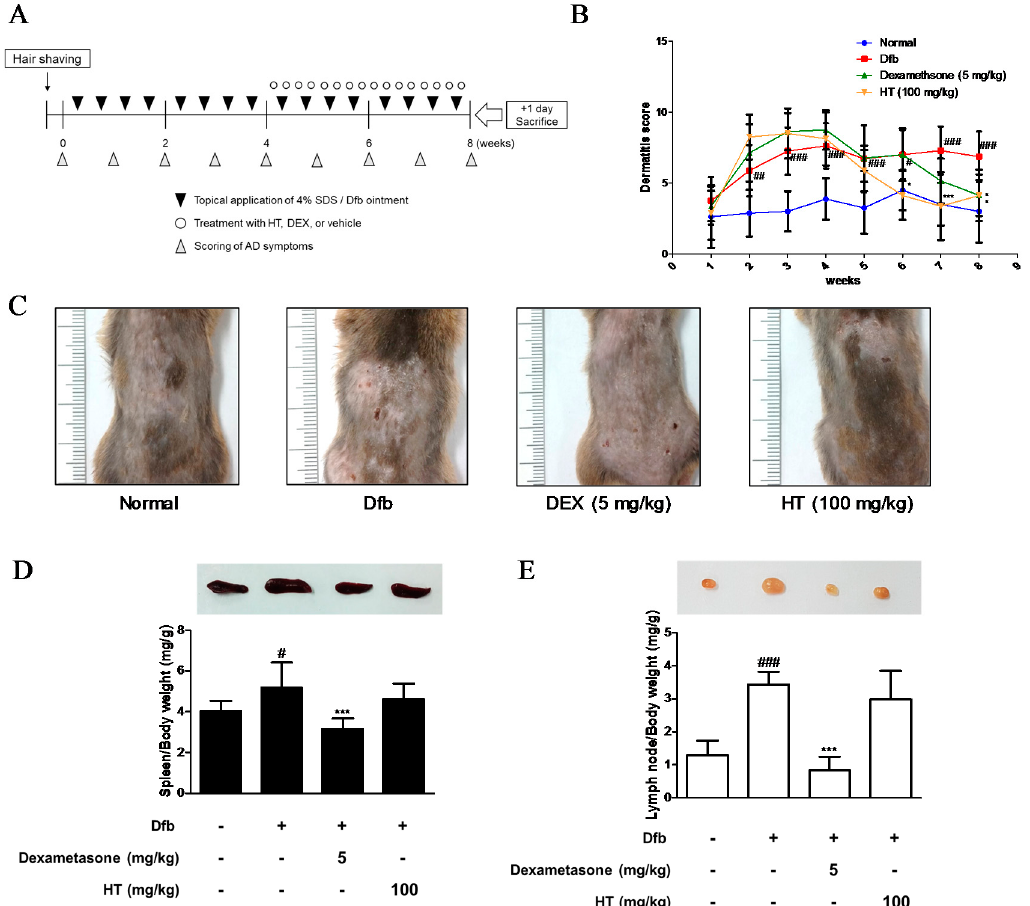
Figure 1. Effects of HT on the development of Dfb-induced AD-skin symptoms in NC/Nga mice. ( A ) Schematic representation of the experiment. Dexamethasone (5 mg/kg, DEX) was used as a positive control. ( B ) Dermatitis scores were measured once a week for 8 weeks. The dermatitis score was defined as the sum of scores graded for each of the symptoms. ( C ) Clinical features of AD-skin symptoms. ( D – E ) Representative size and weight of spleen and lymph node were compared by photographic images. Organs/whole body weight were measured. The data shown represent mean ± standard deviation (S.D.) of three independent experiments. # p < 0.05, ## p < 0.01, ### p < 0.001 vs. the control group; * p < 0.05, and *** p < 0.001 vs. Dfb-treated group. SDS: sodium dodecyl sulfate; Dfb: Dermatophagoides farina body; HT: H. tuberosus ; AD: Atopic